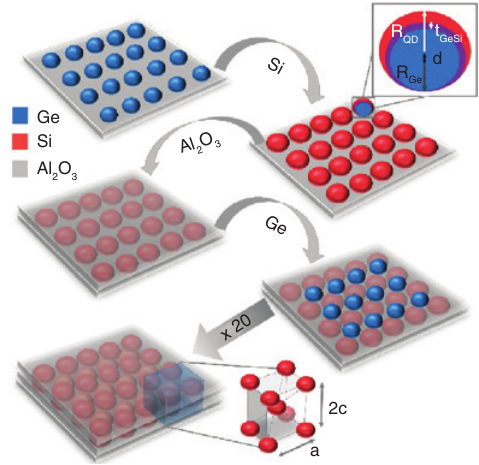
O /Ge/Si multi- 2 3